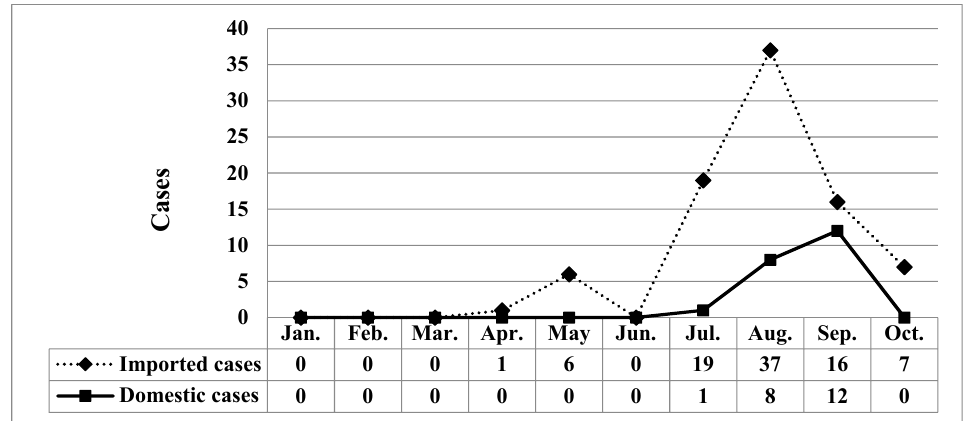
Figure 2. Monthly distribution of chikungunya associated with domestic and imported patients during 2019.